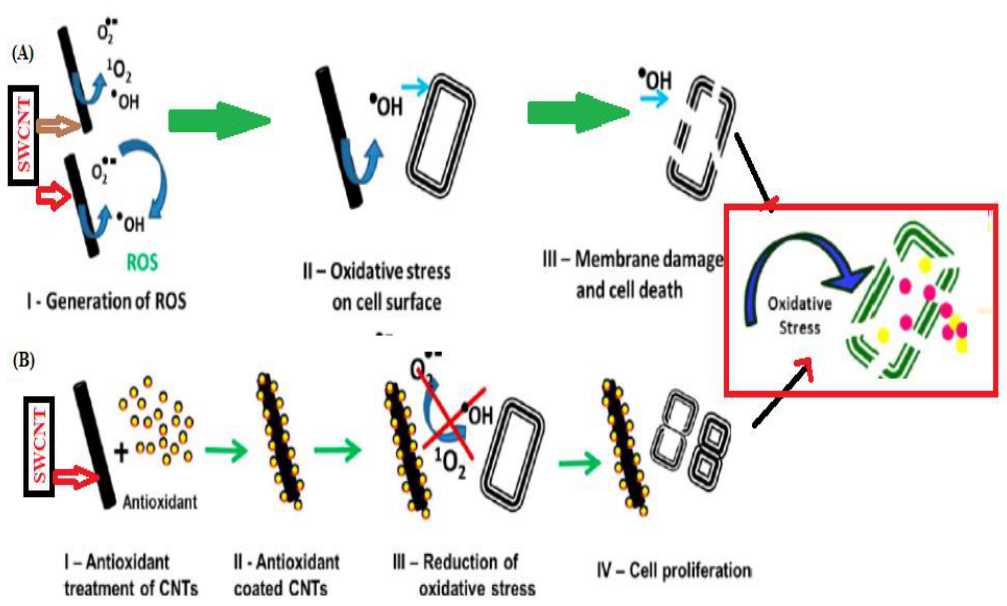
Figure 5. Schematic representation of oxidative stress-mediated cell death and its amelioration by antioxidant treatment. ( A ) Oxidative stress (ROS)-mediated bacterial cell death. ( B ) Protection of bacterial cells against oxidative stress by an antioxidant [24] (modified image and Reproduced with permission and cited in the reference, from ACS chemical Society).